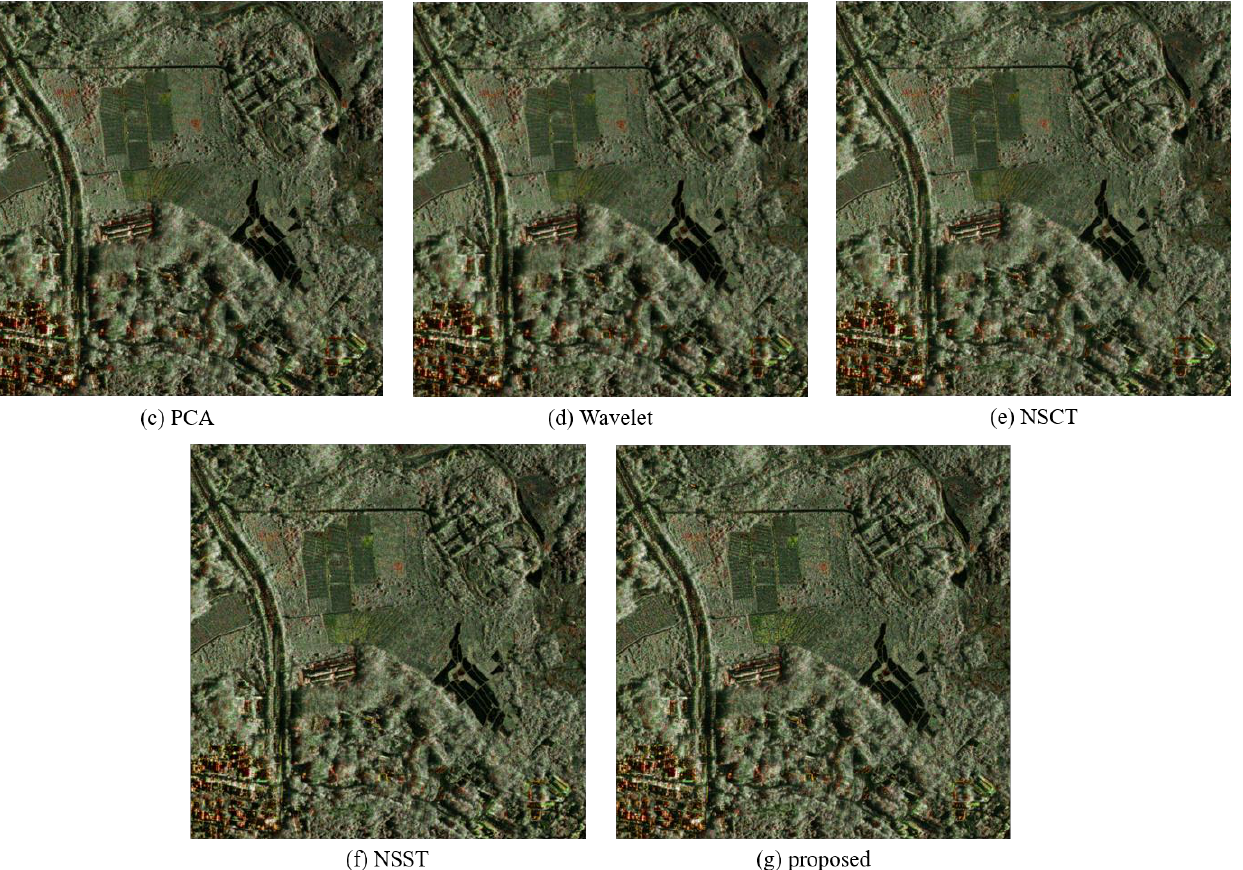
Figure 11. Complete colorization fusion results of scene 1: ( a ) Band difference map: ( b ) polarization difference map; ( c ) PCA fusion; ( d ) wavelet fusion; ( e ) NSCT fusion; ( f ) NSST fusion; and ( g ) proposed method fusion.